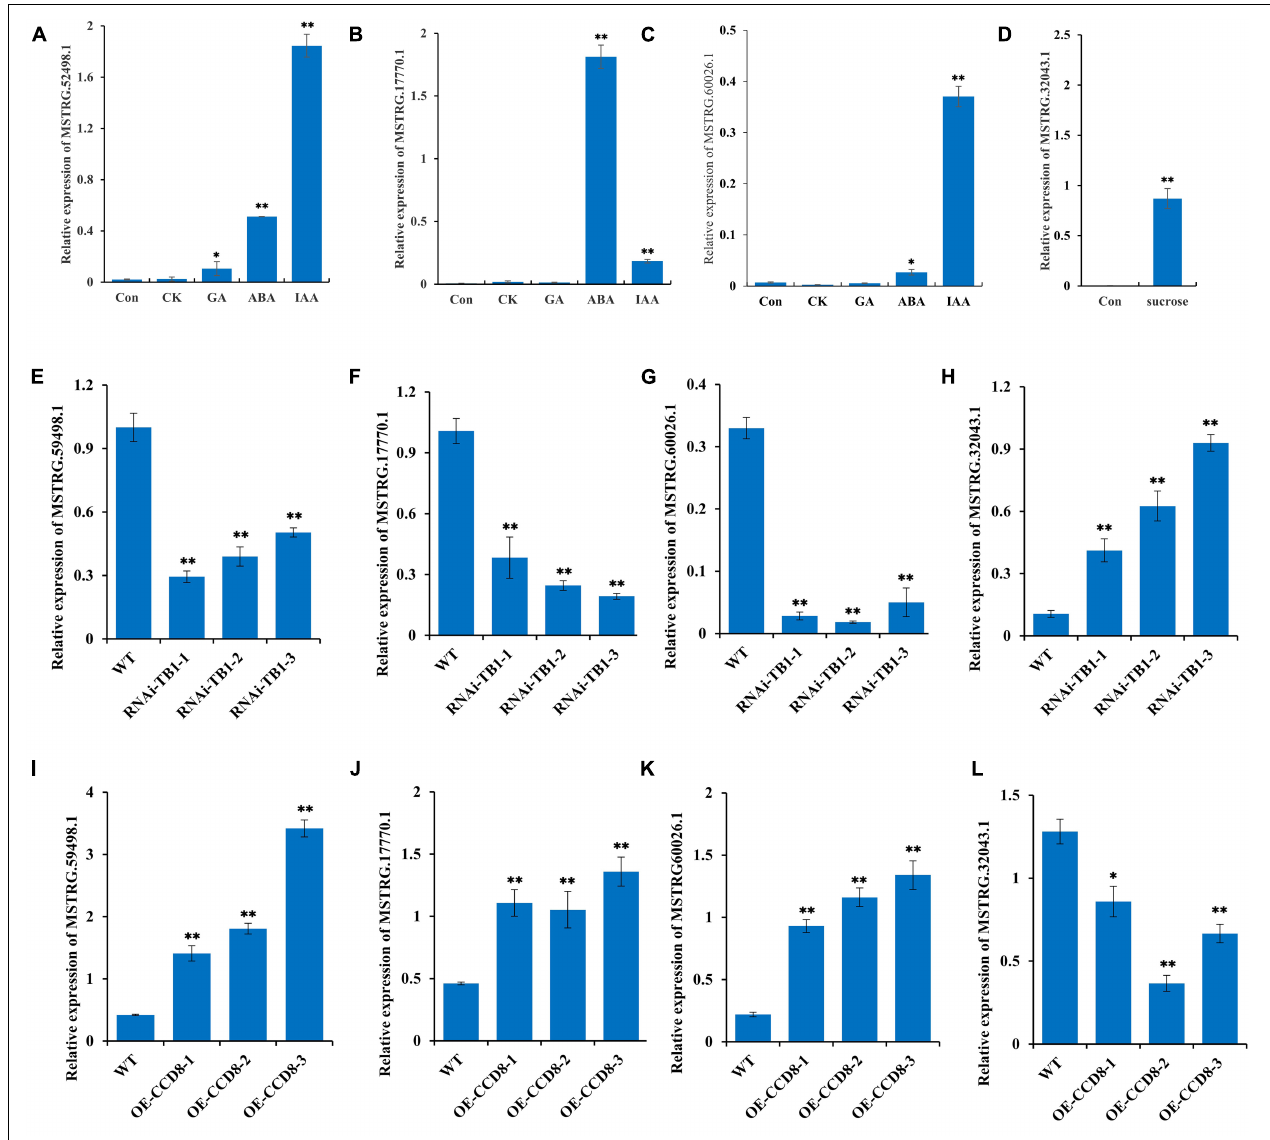
FIGURE 8 | Functional verification of four lncRNAs following treatment with hormones and sucrose in transgenic plants. (A–C) Expression levels of MSTRG.52498.1, MSTRG.60026.1, and MSTRG.17770.1 following treatments with different hormones (IAA: indole acetic acid; CTK: cytokinins; ABA: abscisic acid; and GA: gibberellic acid). (D) Expression levels of MSTRG.32043.1 following treatment with sucrose. (E–H) Expression levels of MSTRG.52498.1, MSTRG.60026.1, MSTRG.17770.1, and MSTRG.32043.1 after RNA interference of NtTB1 in tobacco plants ( NtTB1 -RNAi). (I–L) Expression levels of